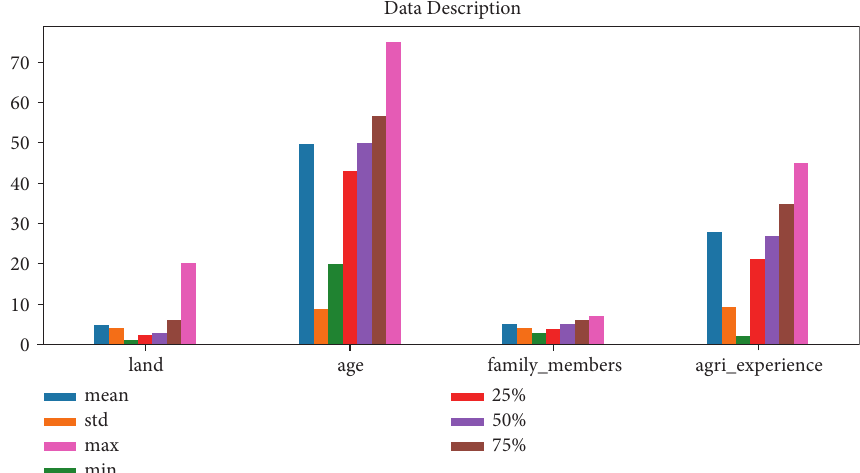
Figure 15: Overview of collected data.